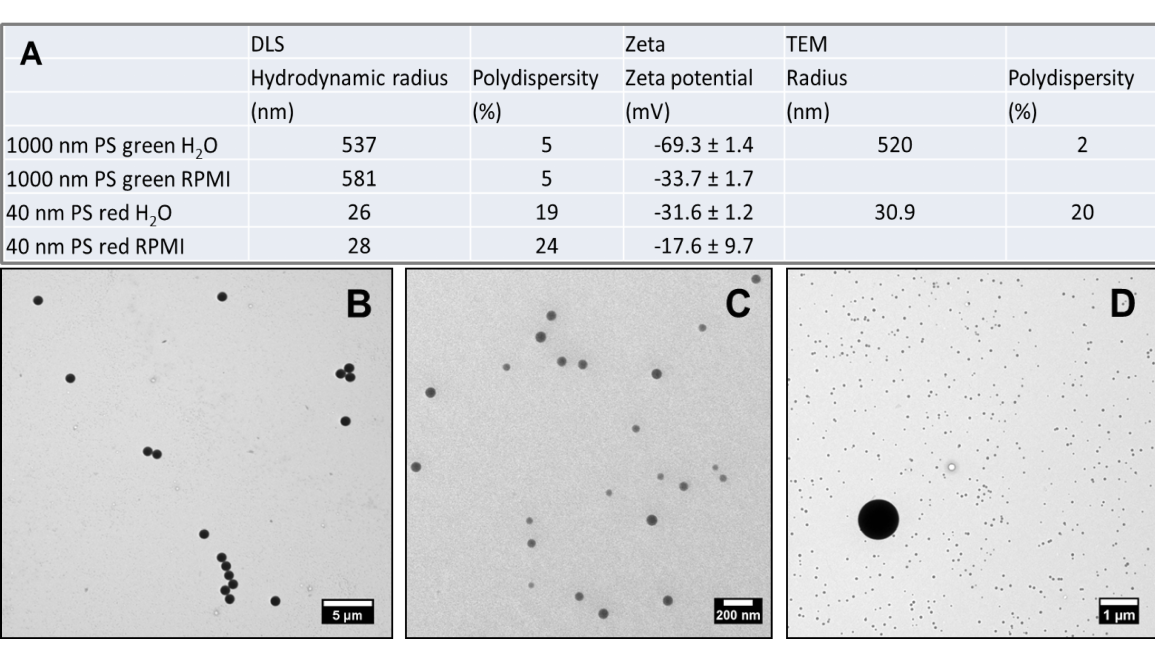
Figure 1: Characterization of polystyrene particles. (A) Characteristics of the particles as measured by dynamic light scattering, zeta potential and transmission electron microscopy in water and unsupplemented cell culture medium. Transmission electron microscopy images of (B) 1 µm particles, (C) NPs, and (D) a mixture of 1 µm particles and